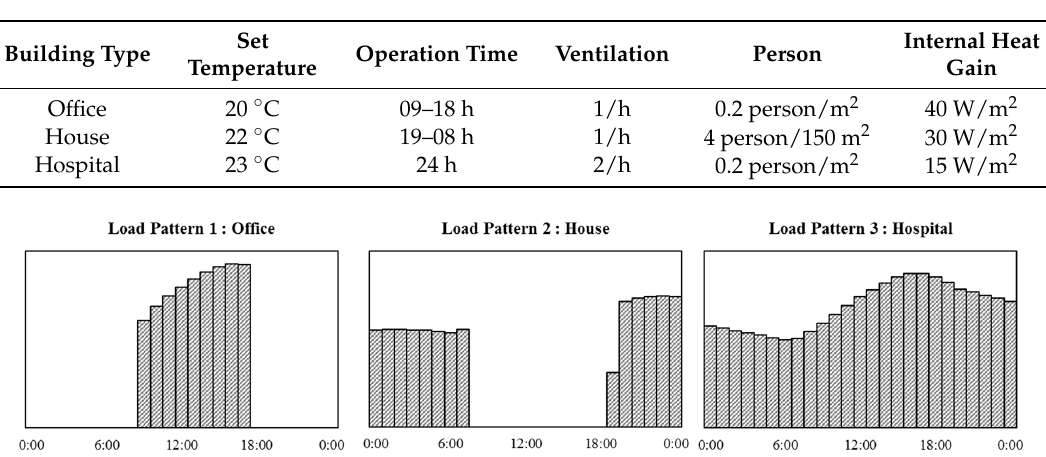
Table 4. Optimization variables.